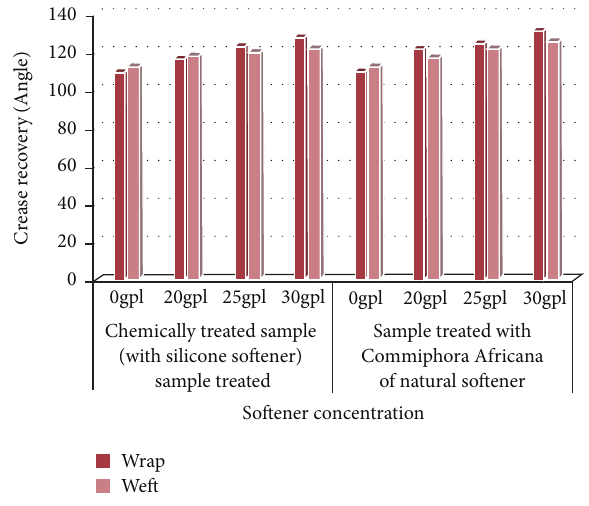
Figure 4: Effect of softener on crease